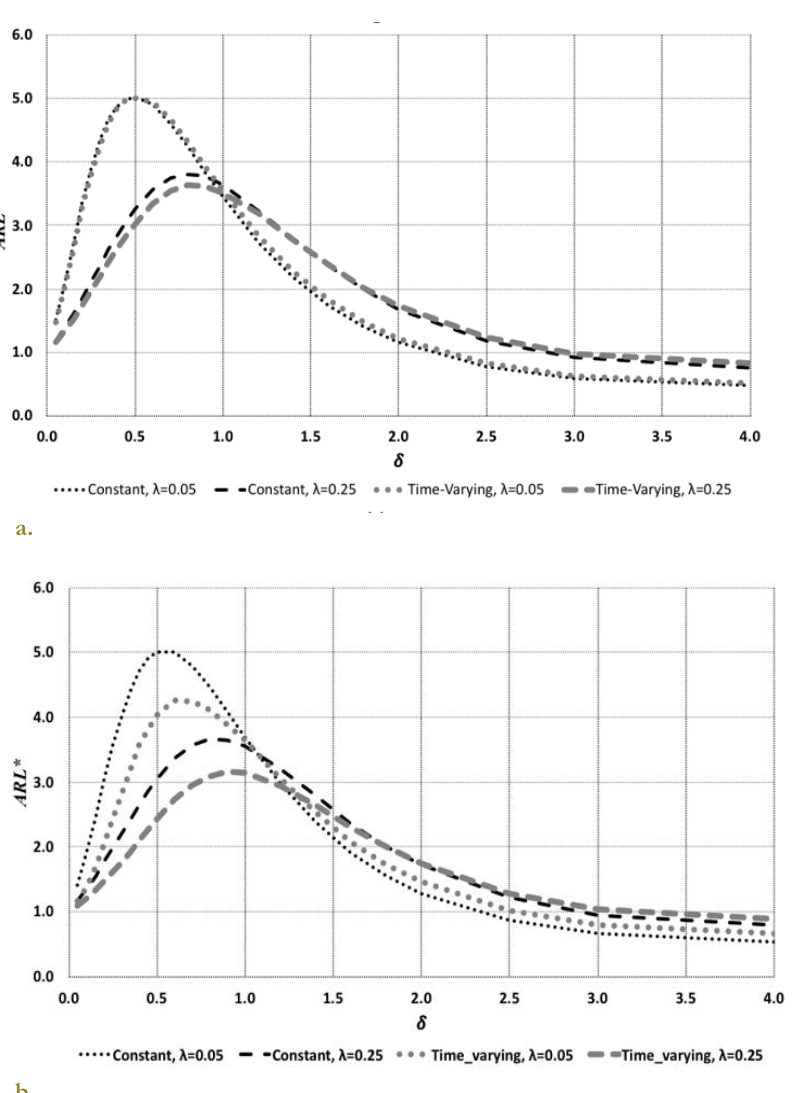
Fig. 5. Steady state 𝐀𝐑𝐋 ∗ profiles for time-varying and CSEWMA with 𝐑 ≊ 2 for; a. 𝐀 = 𝟎 , b. 𝐀 = −𝟎. 𝟐